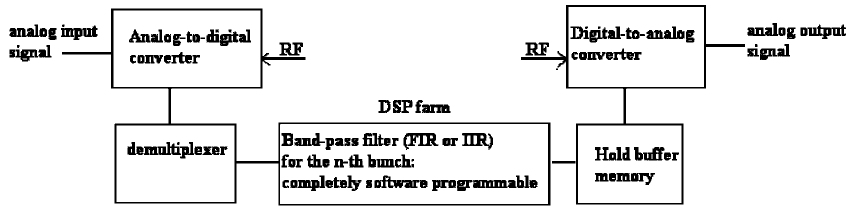
FIG. 3. Block diagram of the LFB digital